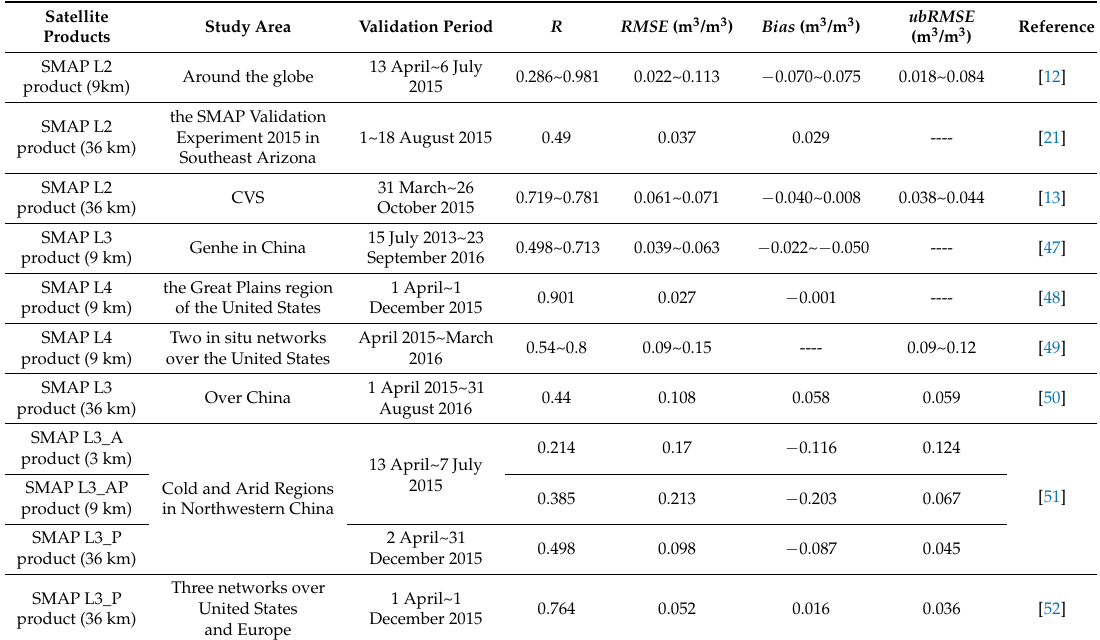
Table 5. Evaluations of the SMAP products with in situ observations in previous